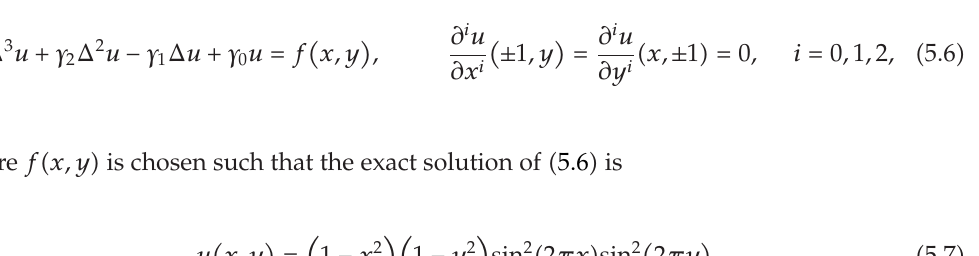
(cid:8) 20 , 30 , 40. N for N